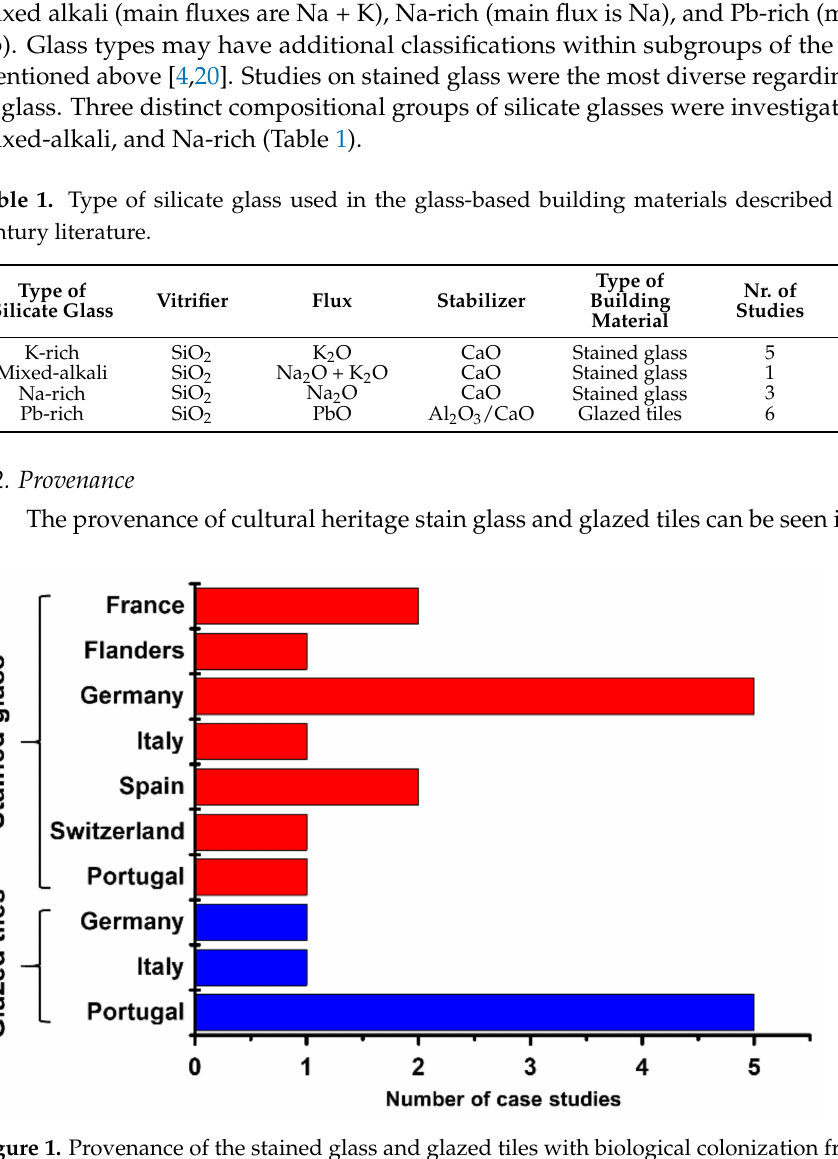
Figure 1. Provenance of the stained glass and glazed tiles with biological colonization from the 21st century